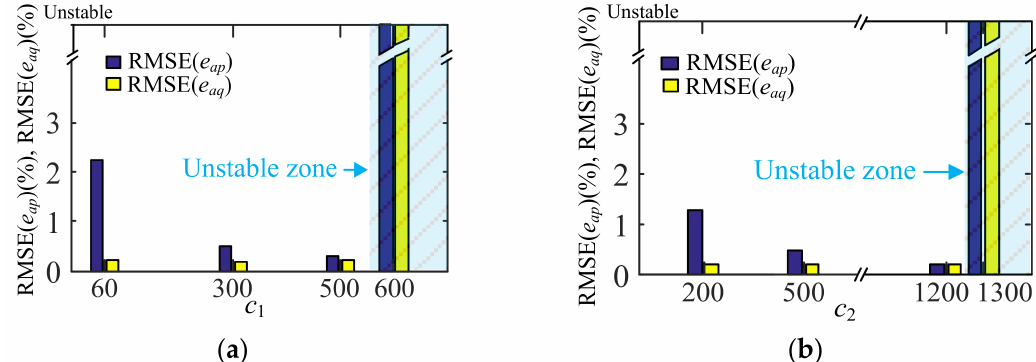
Figure 10. Numerical simulation results of power allocation errors at different parameter values ( c 1 and c 2 ) of proposed TSMC-based P-U/Q-f droop controller: ( a ) c 1 varying; ( b ) c 2